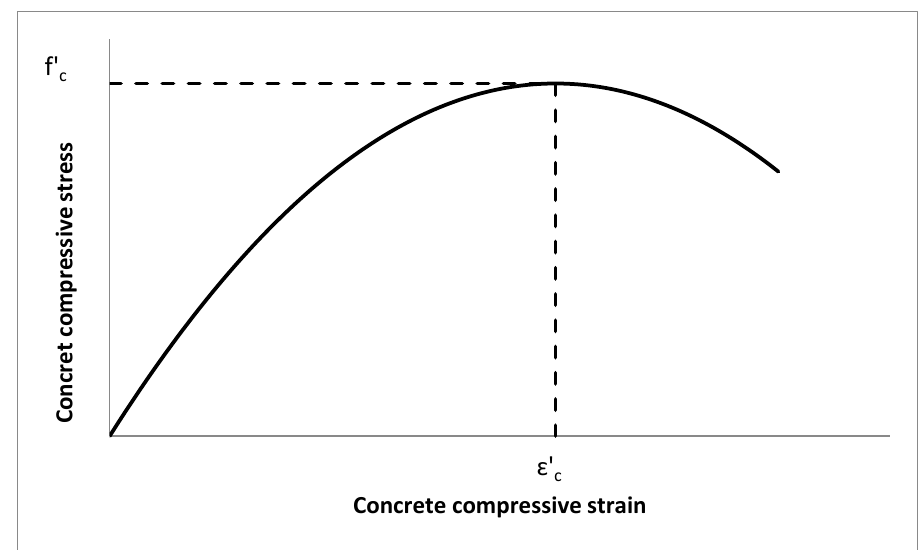
Figure 3. Concrete compressive stress–strain curve (Hognestad’s Parabola [11]).